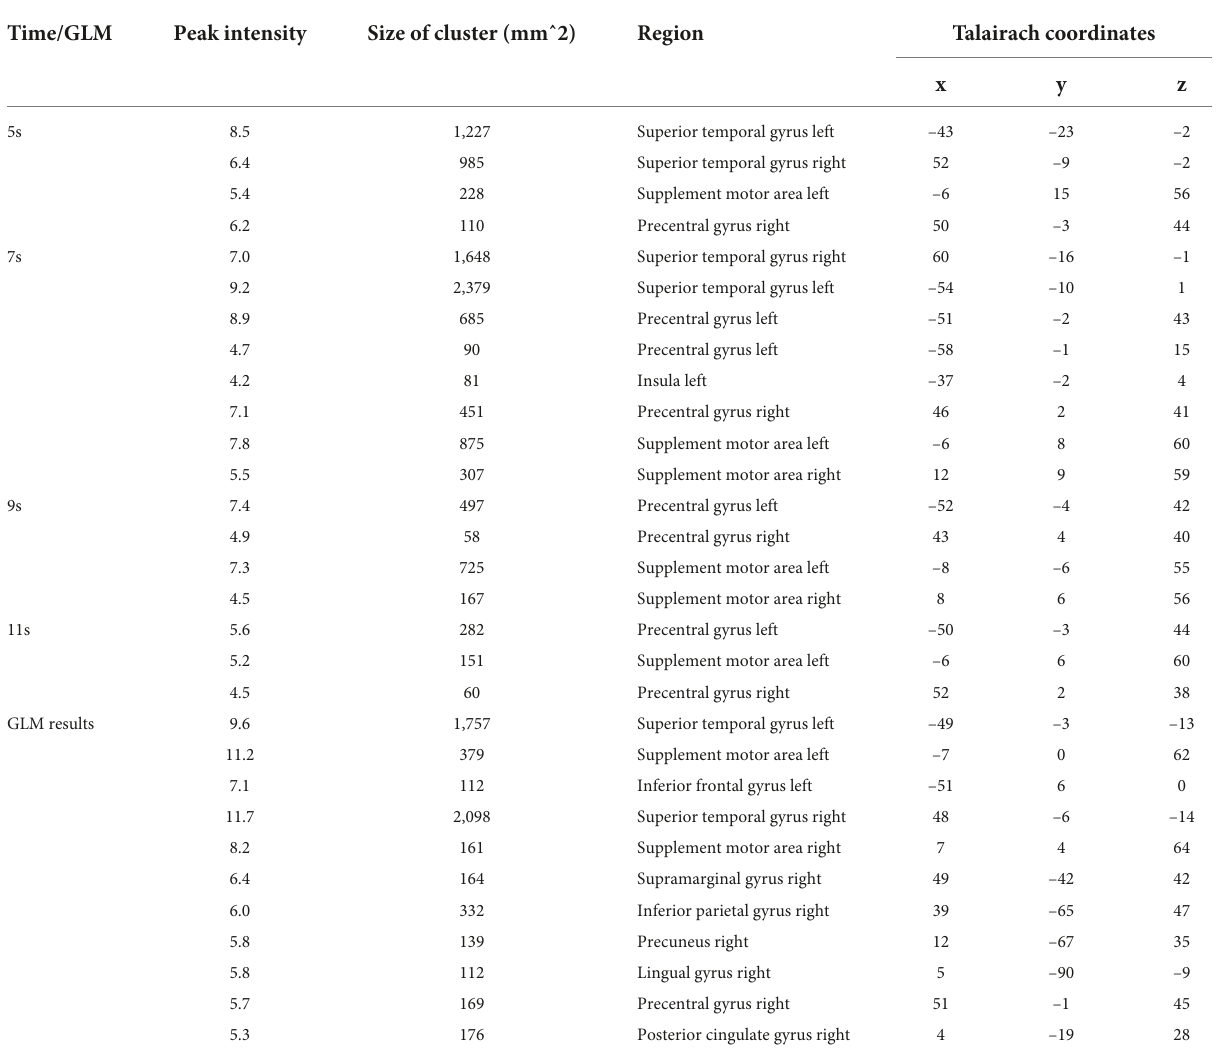
TABLE 3 Results of SSVM-MVPA and GLM